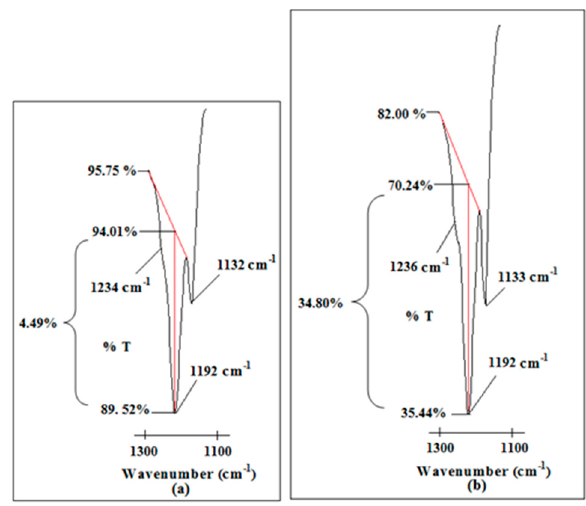
Figure 11. The changes in peak intensity of CF 3 symmetric stretching mode of LiTFSI in ( a ) Ti 0 and ( b ) Ti 3.